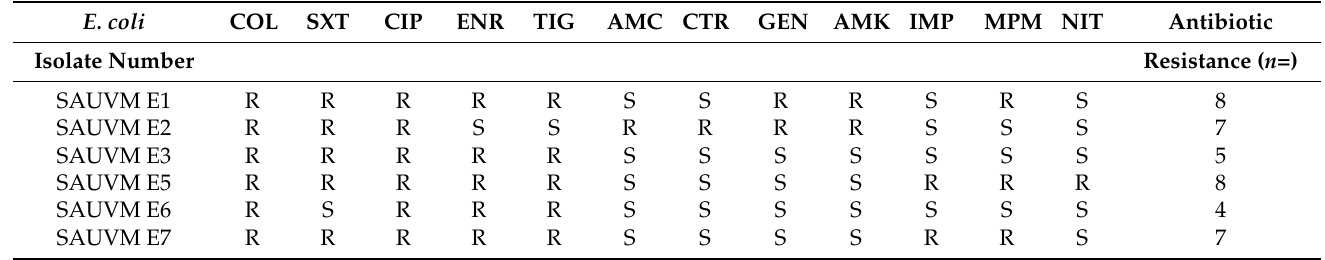
Table 4. Multidrug resistance patterns among mcr-1 -positive E. coli isolates in the present